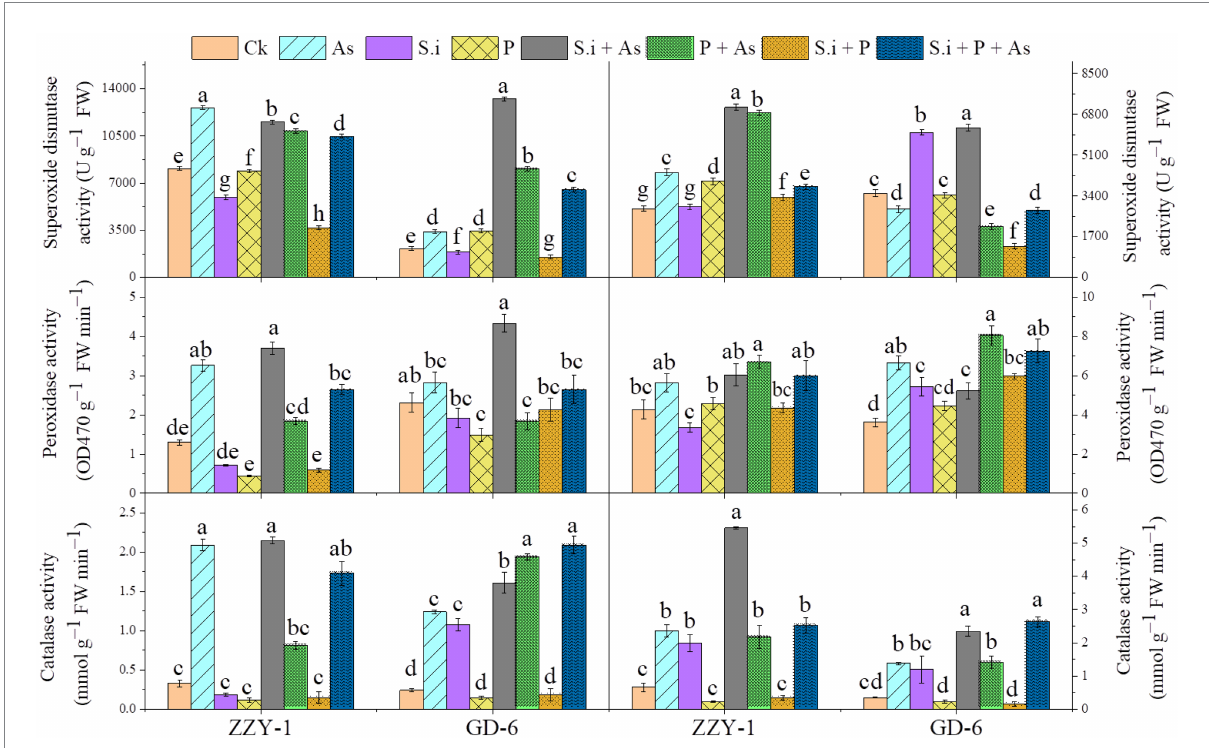
FIGURE 5 Levels of ROS scavenging enzymes in two rice genotypes differing in As accumulation tendency following alone and combined interactions of Serendipita indica symbiosis and phosphorus application against As stress. Right panel represent root and left shows analysis of antioxidant enzymic activities in leaves. Vertical bars represent the means of three independent replicates (±SE). Different letters represent significant difference ( p ≤ 0.05) among the treatments within each